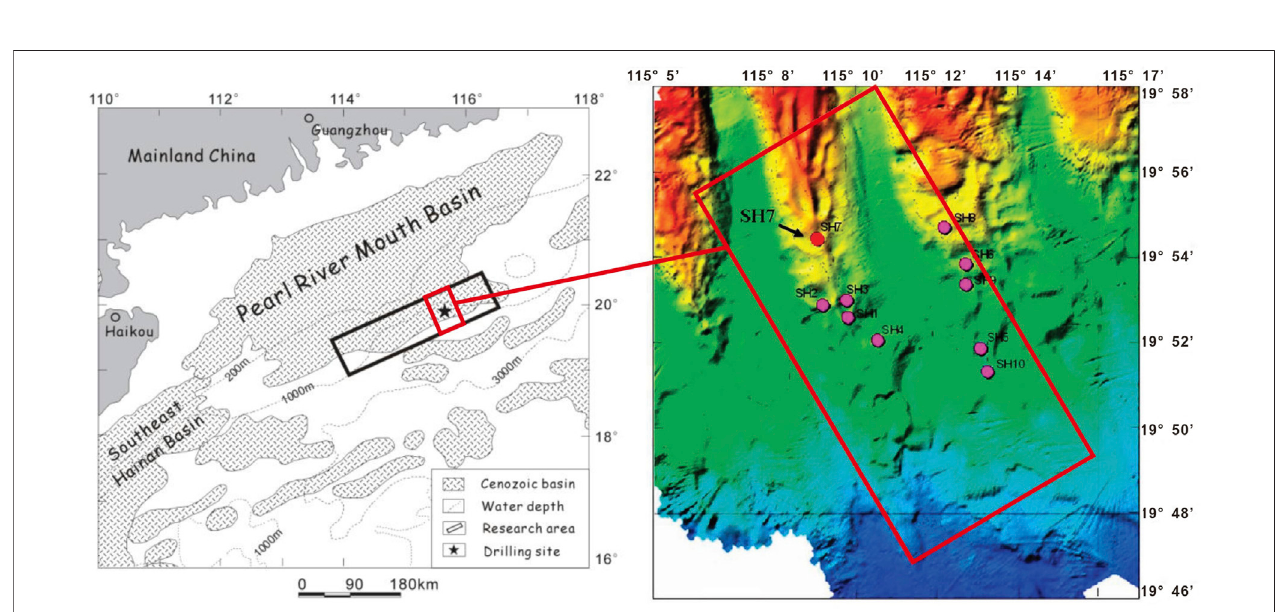
FIGURE 2 | Location of the Shenhu area, South China Sea (Wu et al., 2011).